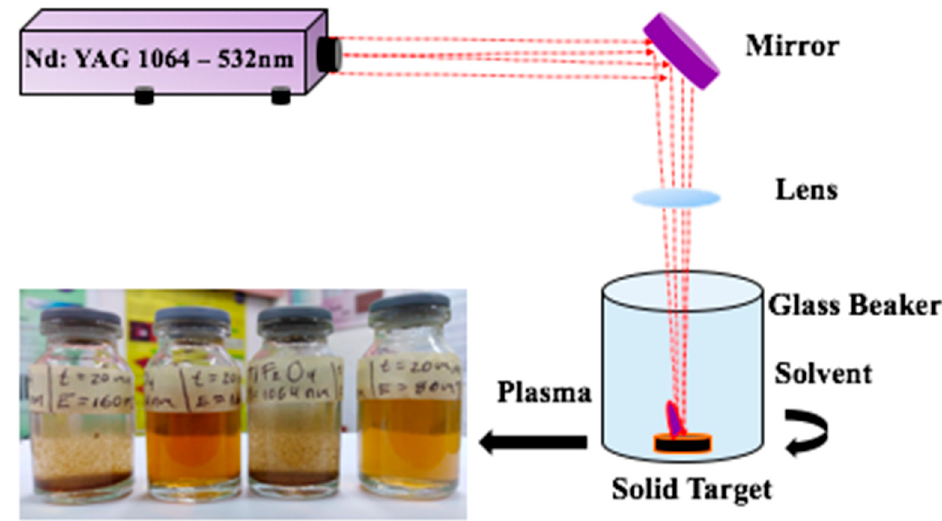
Figure 1. Experimental set-up used for laser ablation in a liquid environment for colloidal nanoparticle (NP) preparation.